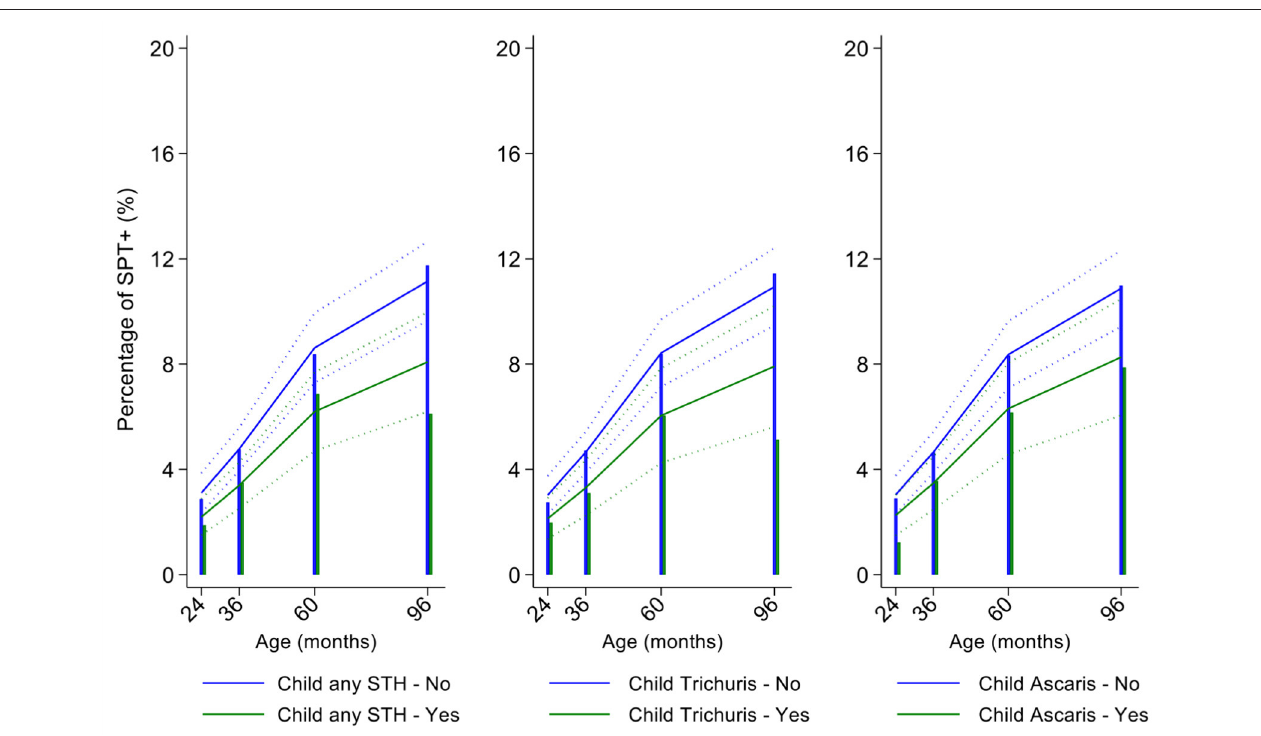
FIGURE 7 | Effect of childhood soil-transmitted helminth (STH) parasites or with specific STH species on age-dependent proportions of cohort children with allergen skin prick test positivity (SPT + ) to mite. Shown are predictions from population average longitudinal models (predictions shown by solid lines and 95% confidence intervals by dotted lines) against raw data percentages (bars). Blue lines/bars—uninfected children; green lines/bars—infected